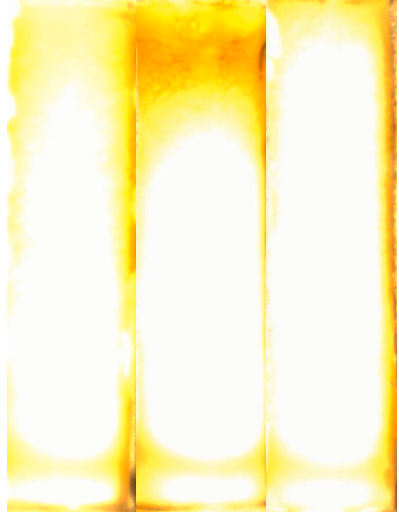
Figure 13. Solidification front images for different geometry of storage units but for the same process time equal to 35 min and the same constant wall temperature condition ( Ts = 17 °C): at left for annular TES, at the middle for shell-and-coil TES with coil position at the bottom of the tank, at the right for shell-and-coil TES with coil position at upper of the tank.